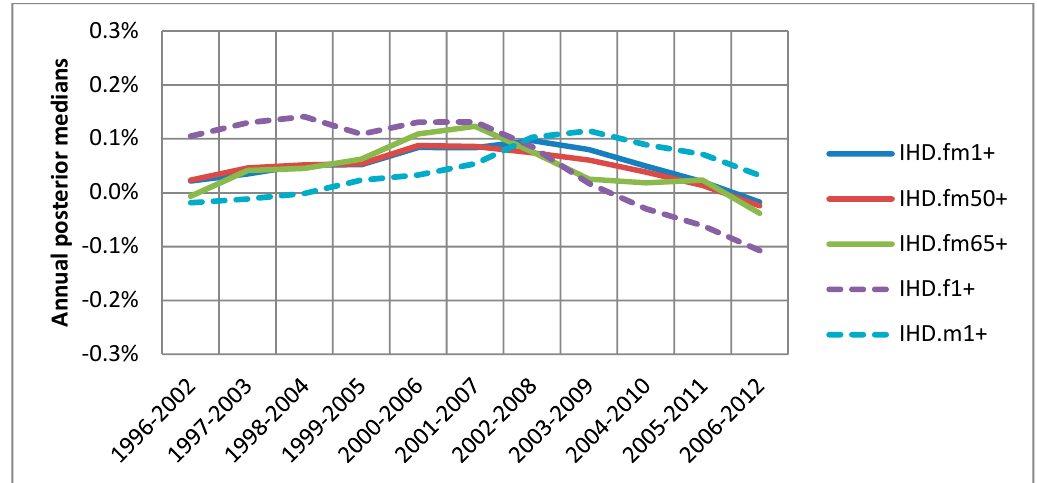
Figure 4. Annual associations between warm season 1-day lagged ozone and IHD hospitalizations for 5 groups: base group (fm1+) in solid blue; over50 group, (fm50+) in solid red; seniors (fm65+) in solid green; females aged ≥ 1 (f1+) in dashed purple; and males aged ≥ 1 (m1+) in dashed blue.